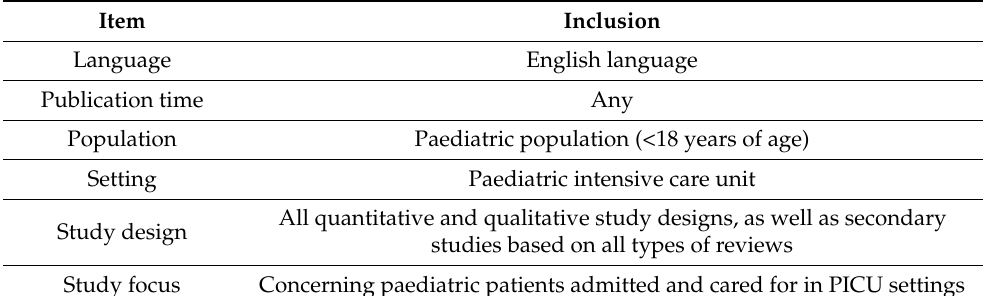
Table 2. Inclusion